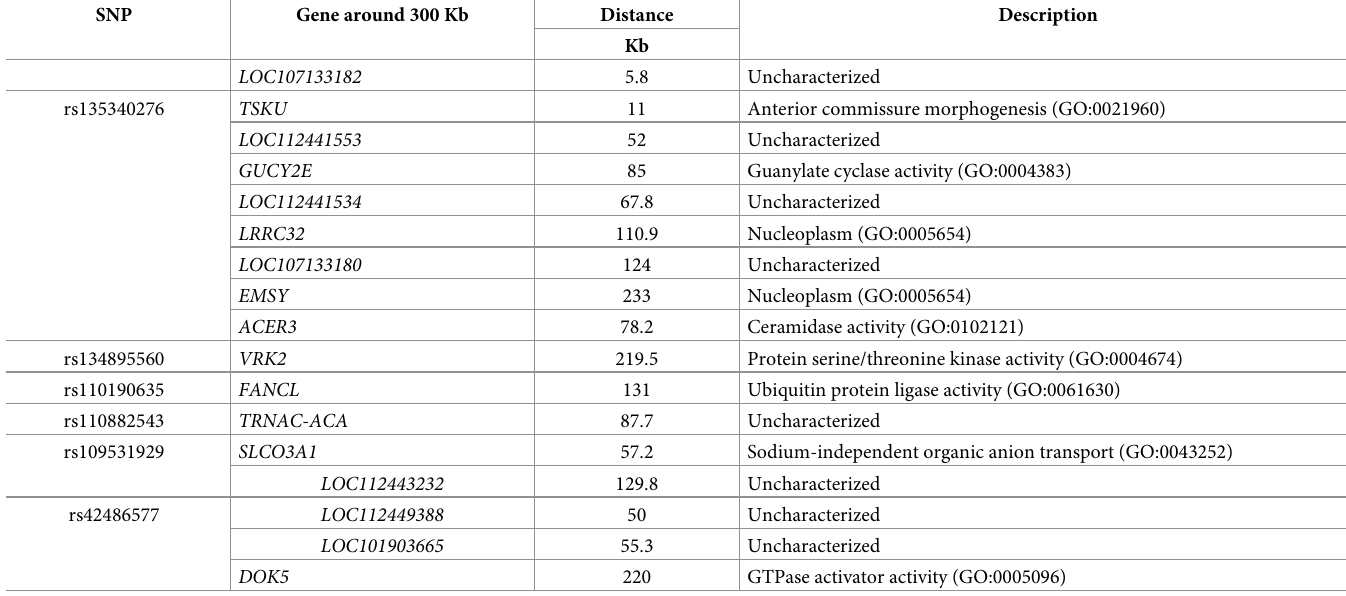
Kb = kilobases, GO = gene